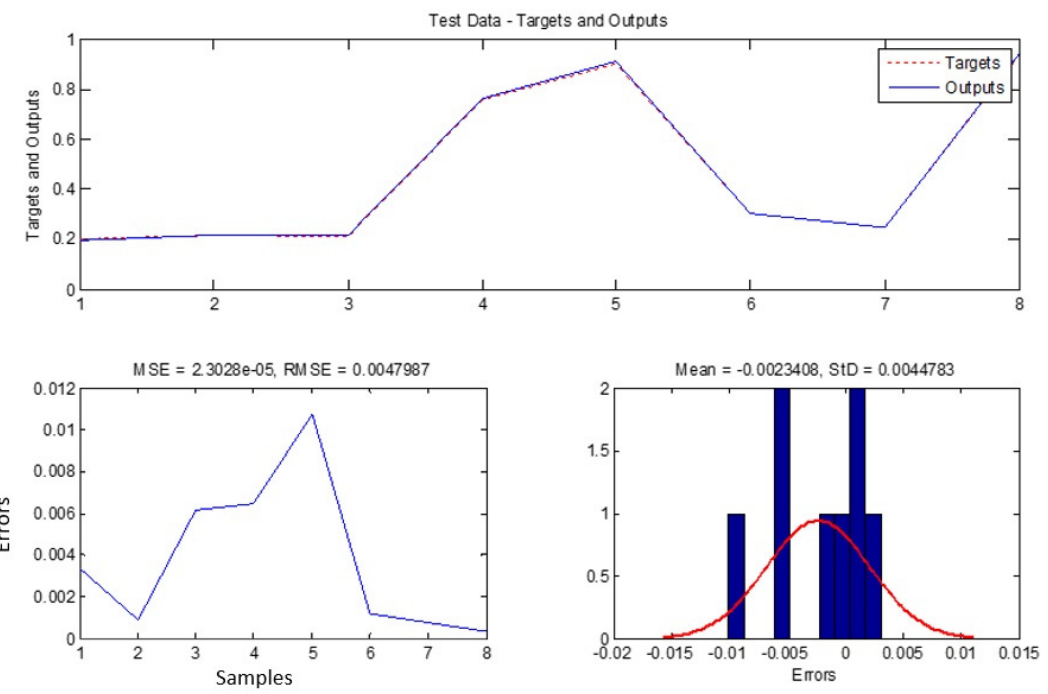
Figure 6. Optimized WOANFIS output and model performance criteria for test data. Table 2. Modeling performance criteria.